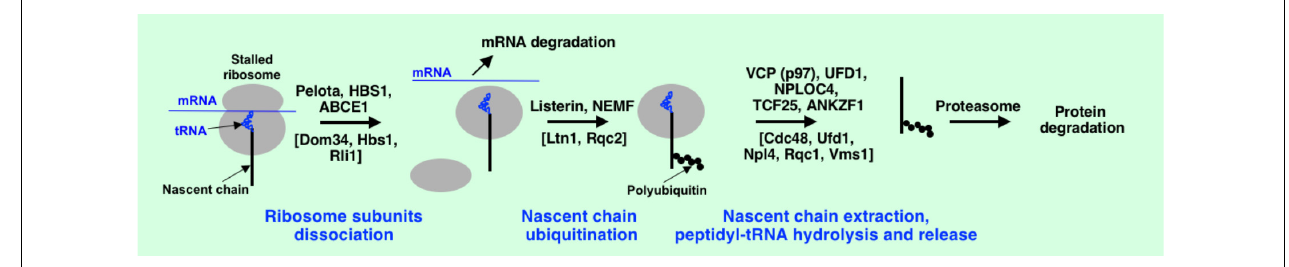
FIGURE 5 | Protein quality control at the stalled ribosomes. Mammalian proteins are shown, their yeast counterparts are in square brackets. See text for details.